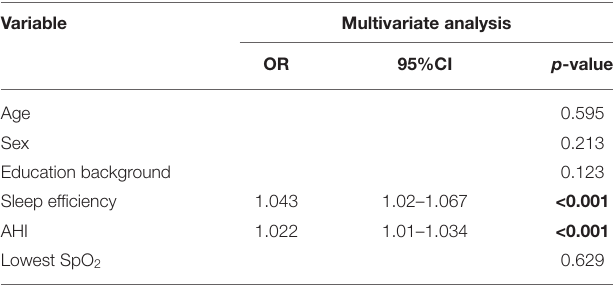
TABLE 3 | Multivariate analyse of independent factors associated with the decisions for titration